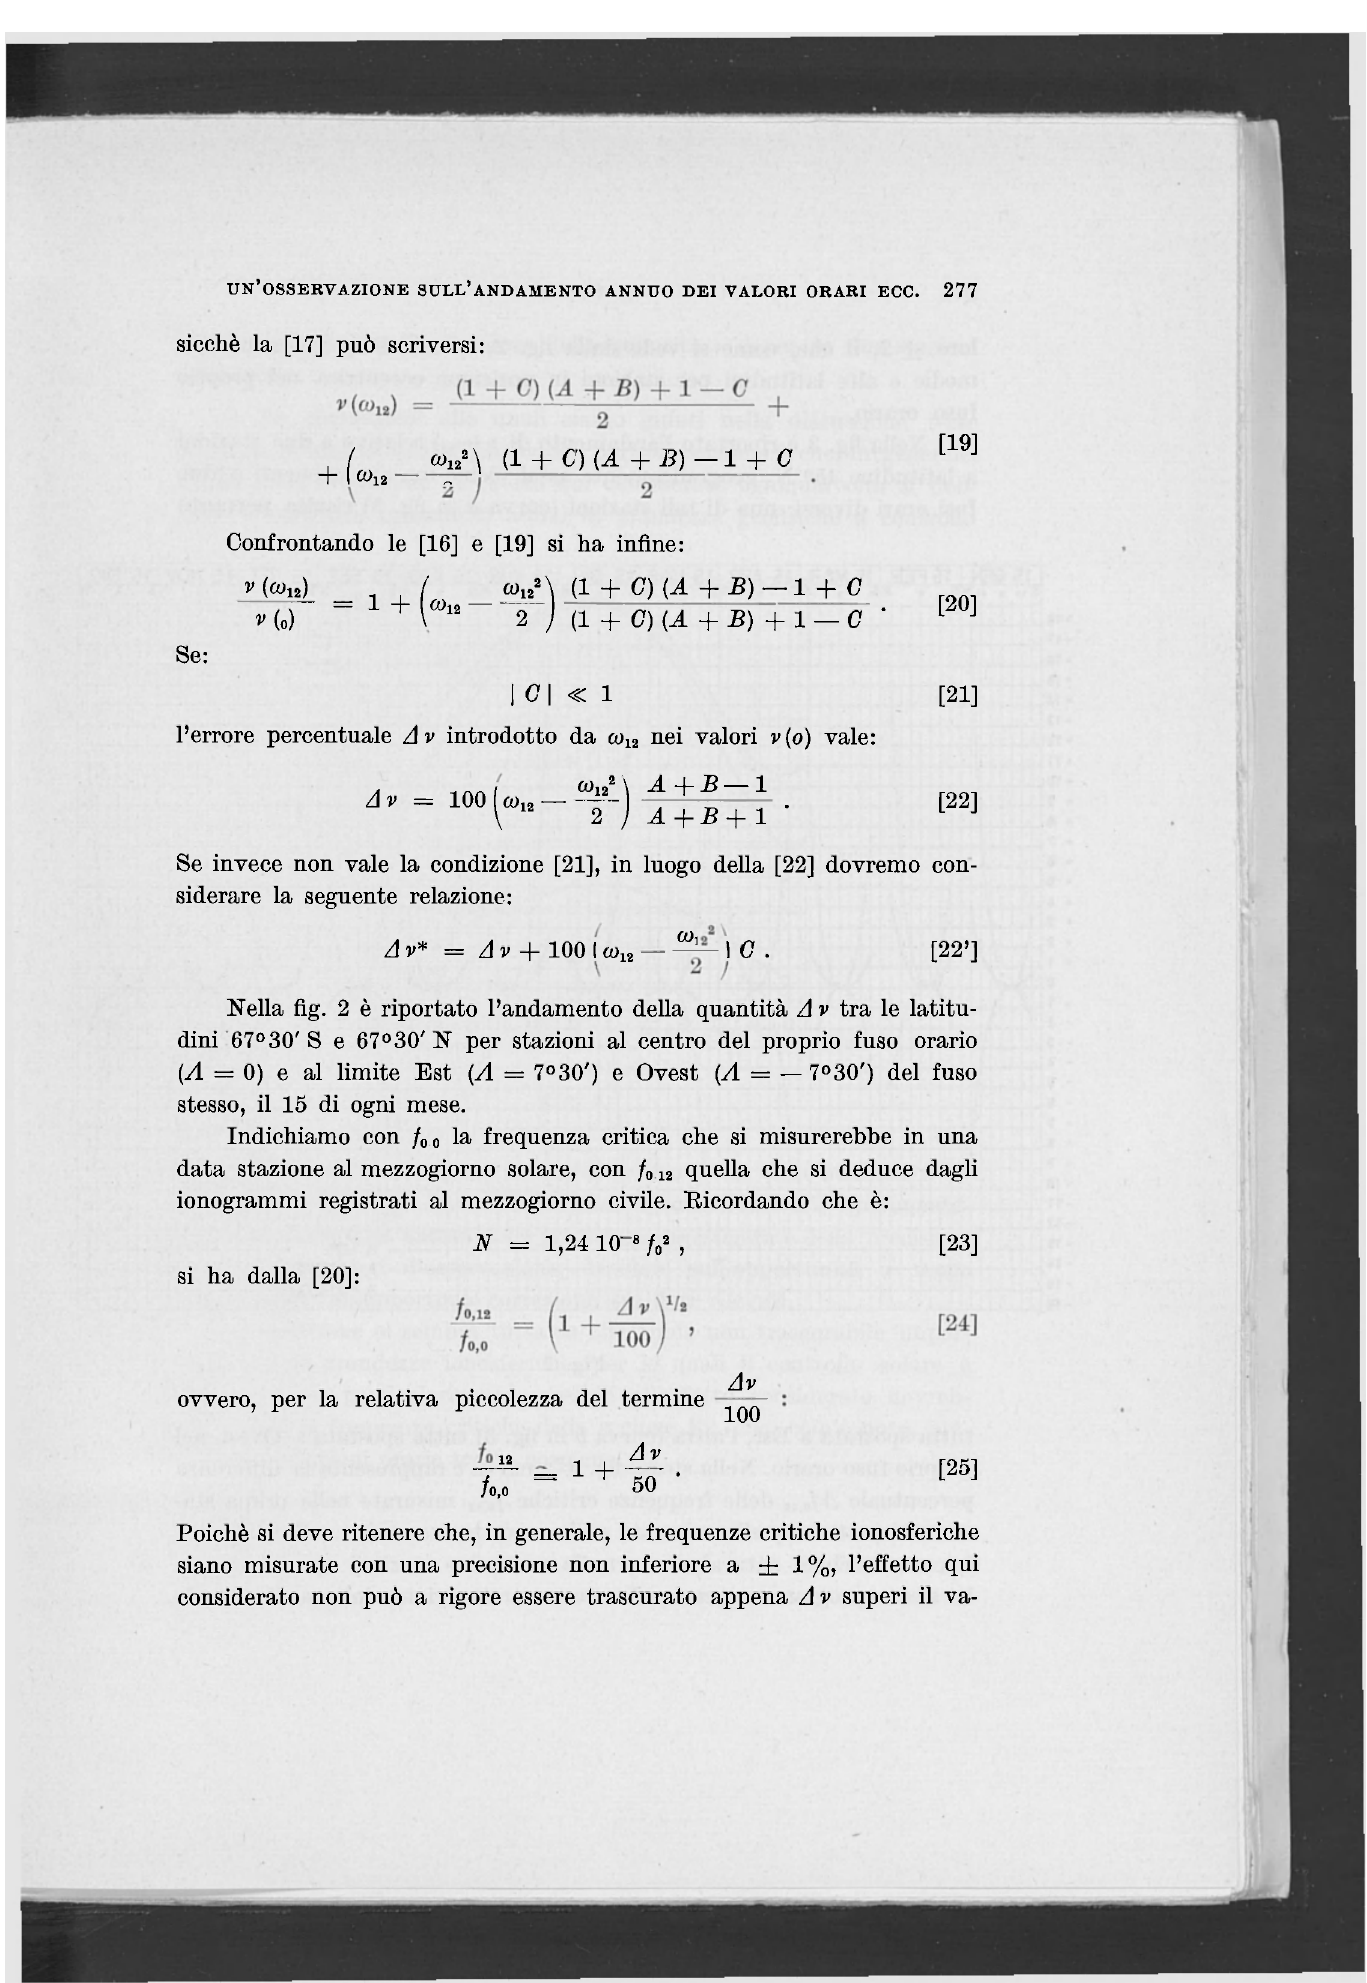
Nella fig. 2 è riportato l'andamento della quantità A v tra le latitu- dini 67°30' S e 67°30' N per stazioni al centro del proprio fuso orario [A = 0) e al limite Est ( A = 7°30') e Ovest (A = — 7°30') del fuso stesso, il 15 di ogni